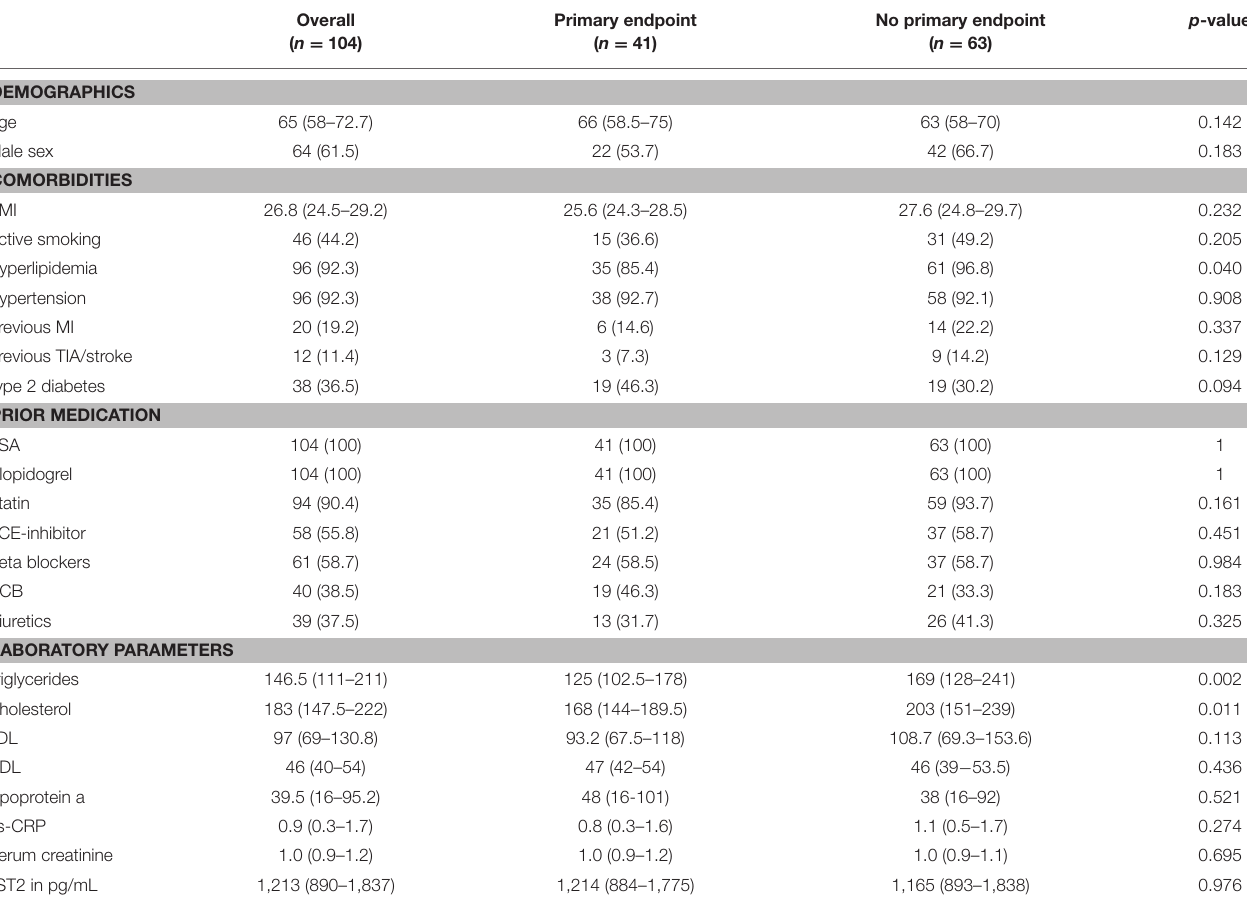
TABLE 2 | Baseline clinical characteristics of the patient population with available follow-up.